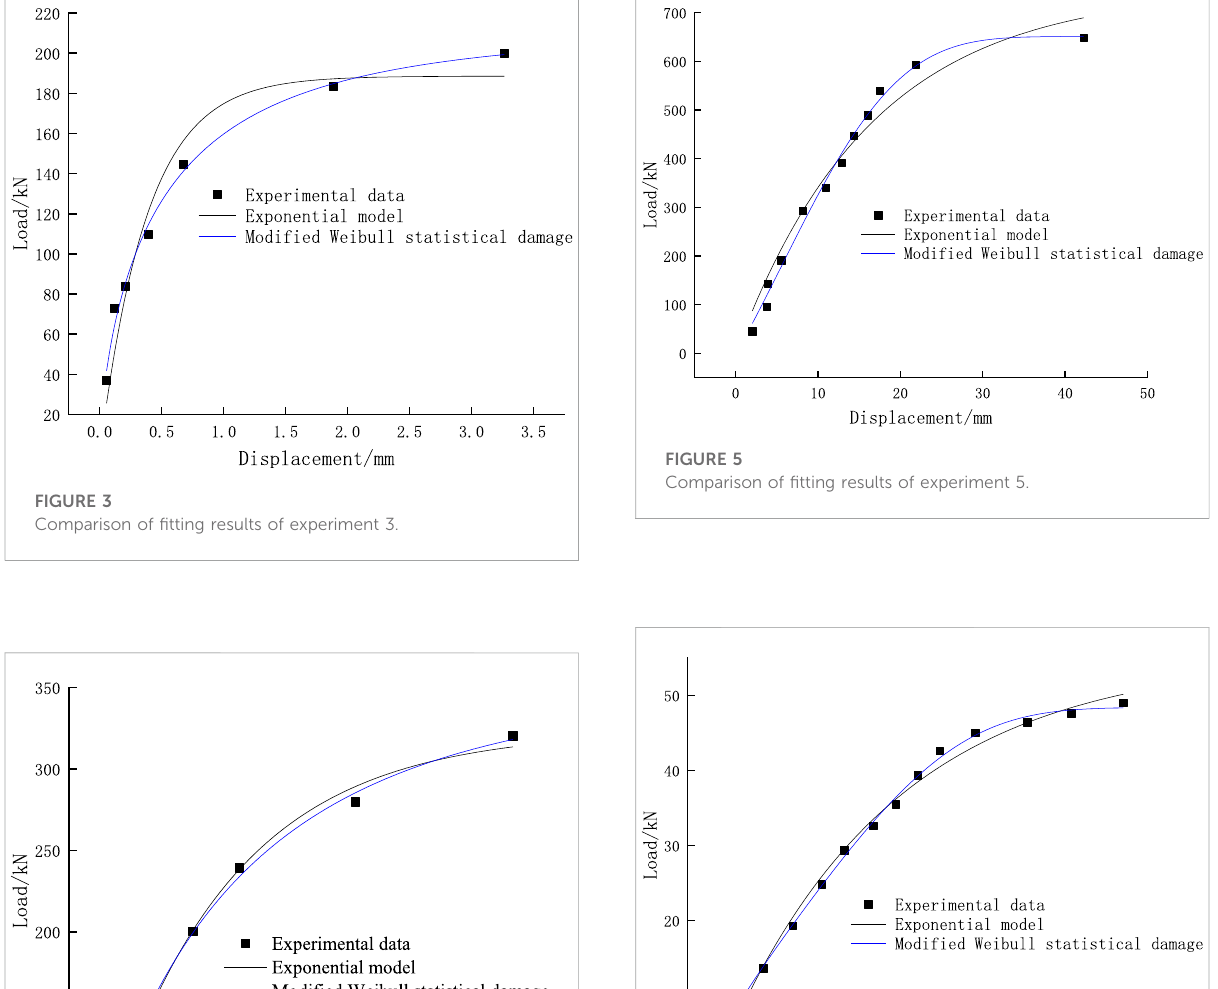
FIGURE 6 Comparison of fi tting results of experiment